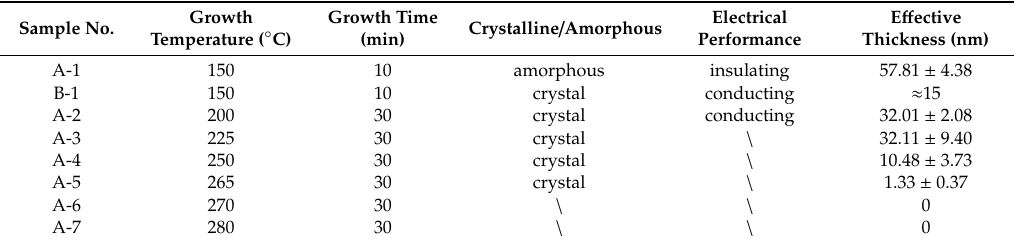
Table 1. Sample list with the growth parameters and properties. Sb 4 molecules were used in the growth of group A samples and Sb 2 molecules were used in the growth of group B samples. “ \ ” means no data were obtained.